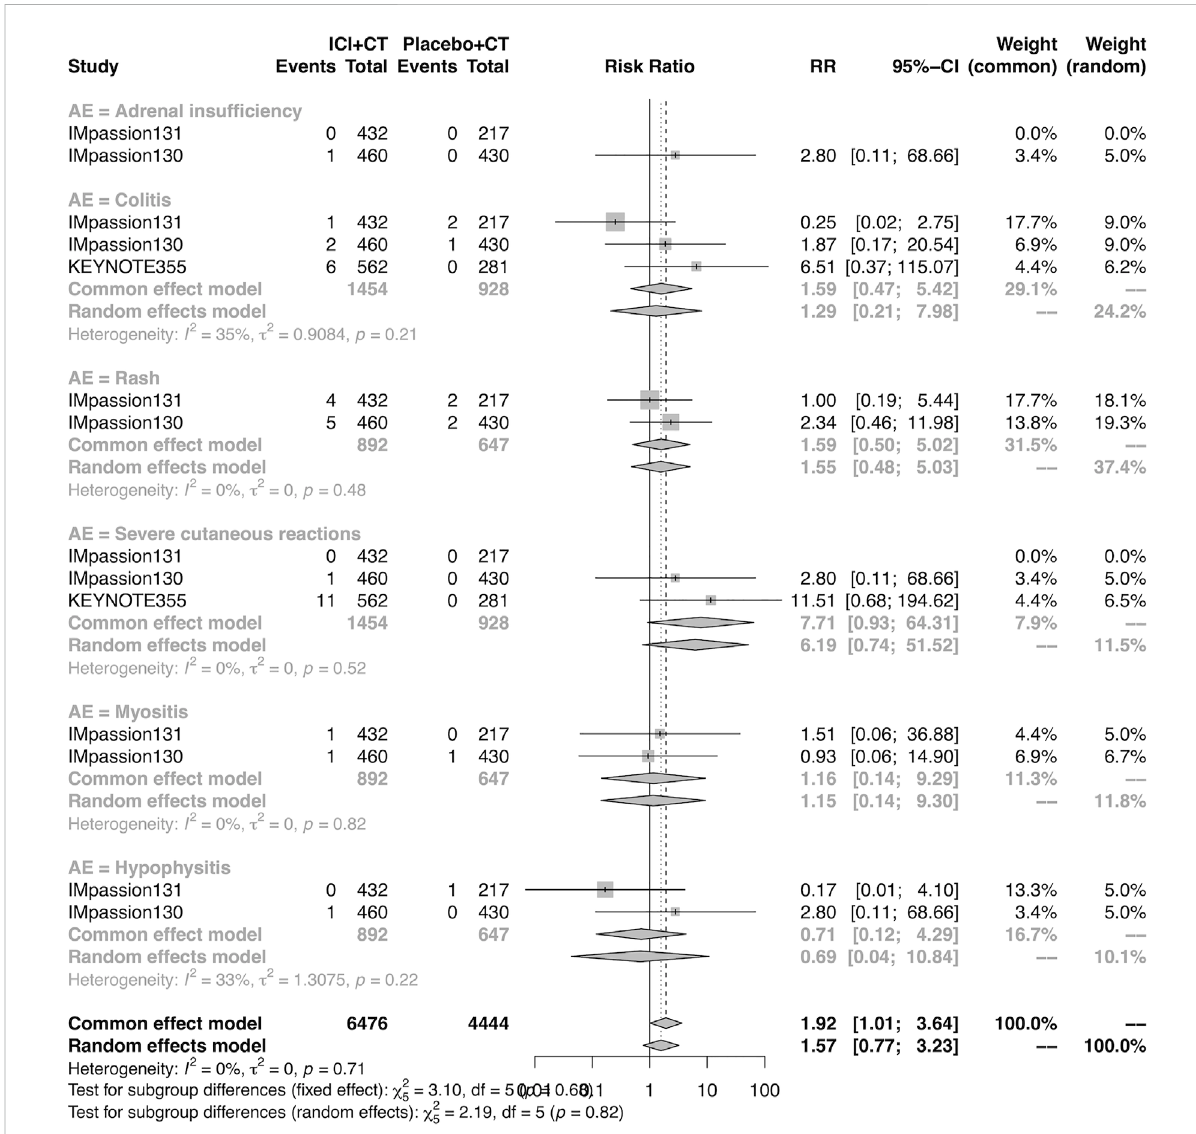
FIGURE 11 Pooledgrade ≥ 3AEsinadjuvanttherapyclinicaltrials:severecutaneousreactions.AEs,adverseevents;RR,relativerisk;95%CI,95%con fi dence interval; ICIs, immune checkpoint inhibitors; CT,